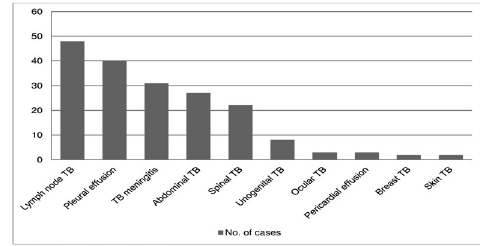
Figure 1: Agegroup-specific sex-wise distribution of TB cases